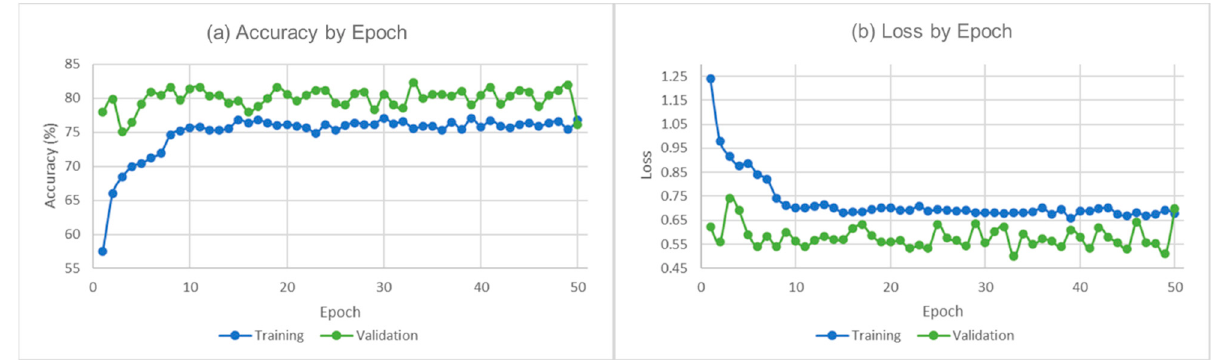
Figure 3. Model accuracy by epoch ( a ) and validation loss by epoch ( b ).